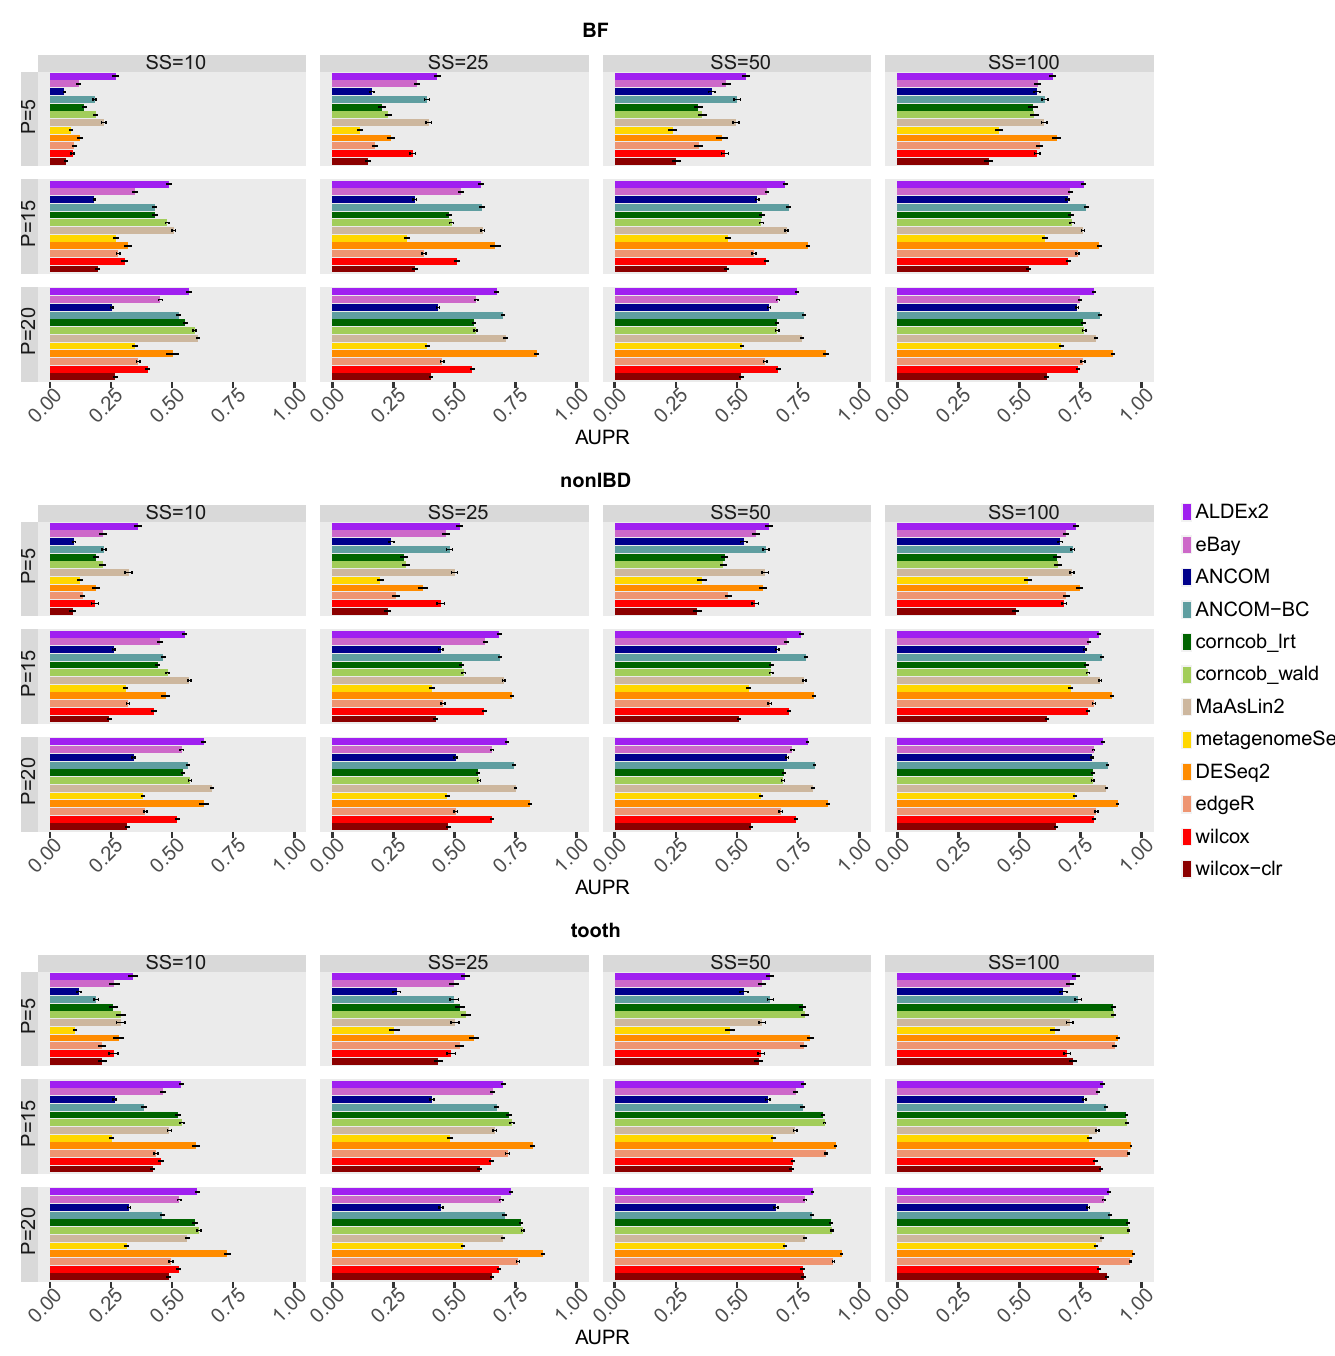
Fig 6. Area Under Precision-Recall curves (AUPR) of each differential abundance method for each dataset considered in the comparison in the main scenario with simulated DA features. In each set of boxes corresponding to the dataset, different percentages (P) of simulated DA features are on rows, while different sample size (SS) values are on columns. The AUPR values are averaged over the 50 simulations and the bars show the standard